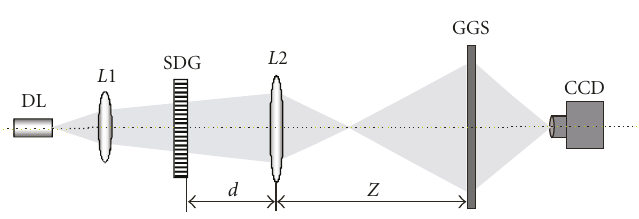
Figure 5: Optical arrangement for determination of frequency content of patterns projected by a sinusoidal phase grating—DL: diode laser, L1, L2: lenses, SDG: sinusoidal phase grating, GGS: ground glass